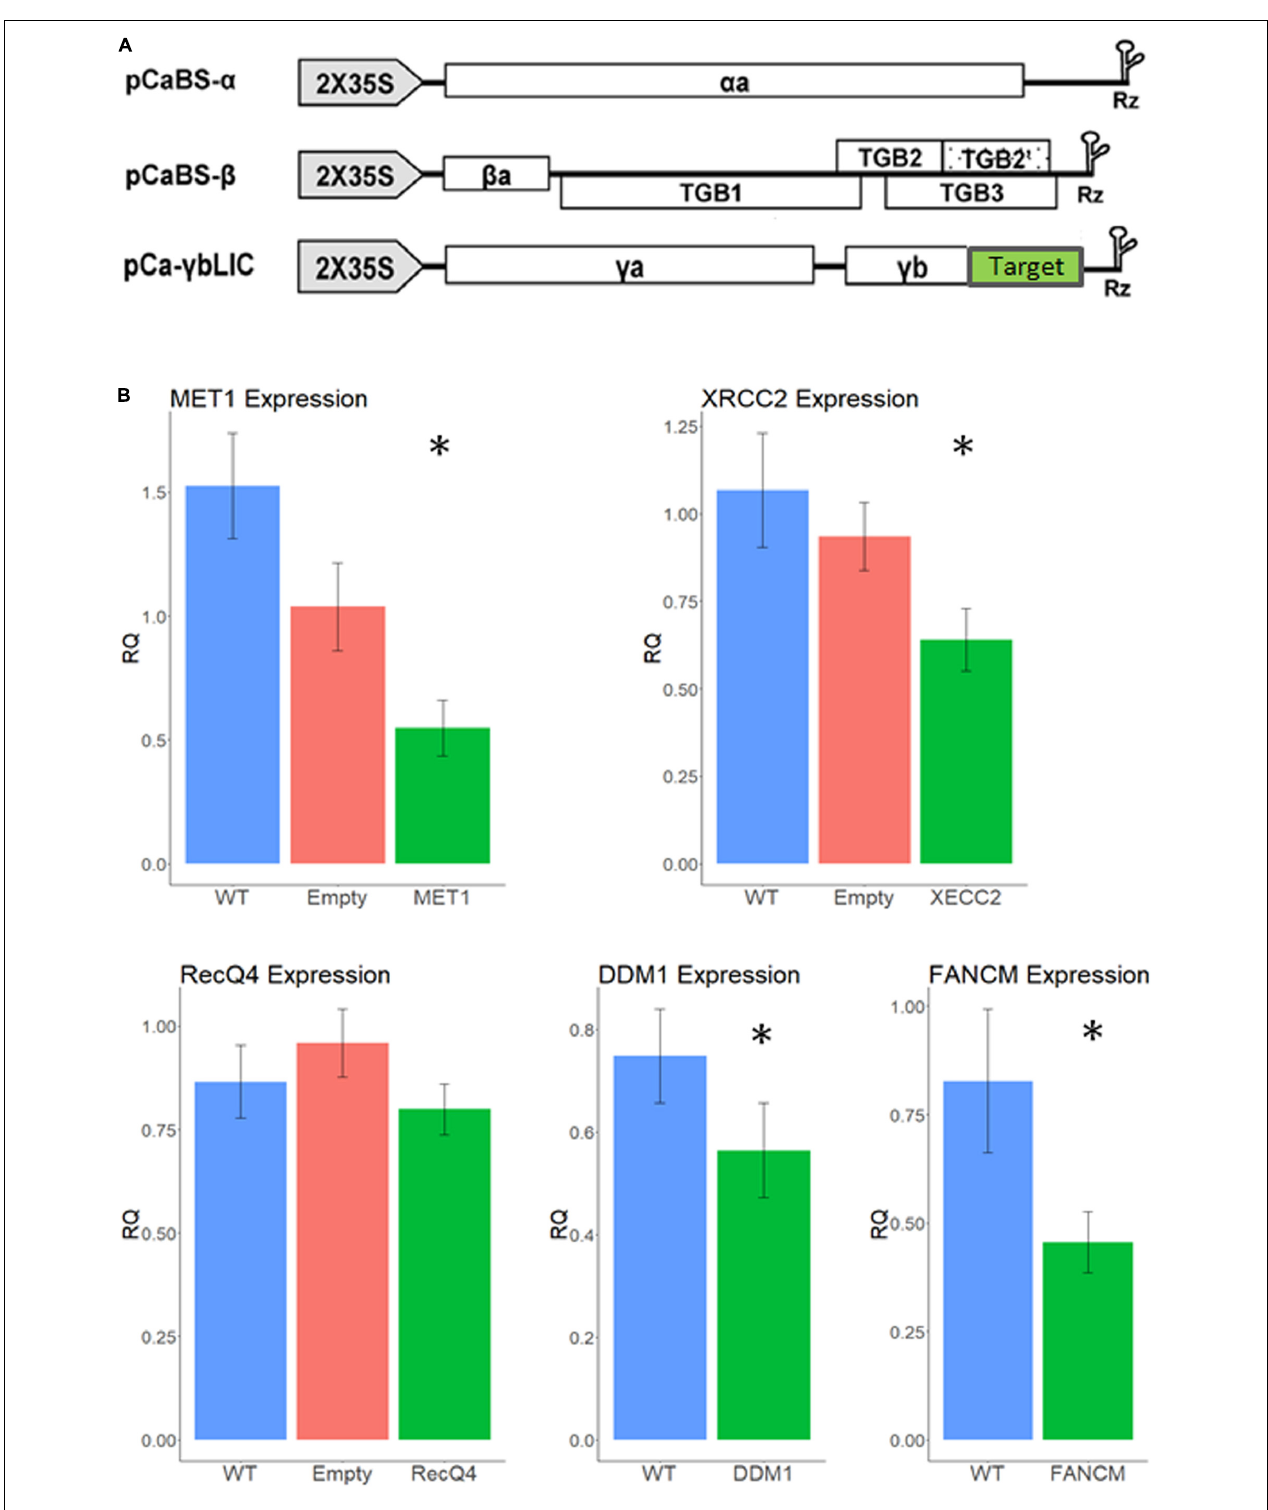
FIGURE 2 | Relative expression levels of recombination suppressor genes after infection with different VIGS treatments. (A) VIGS constructs. Each of the three BSMV sub-genomes was cloned into the pCass4-Rz binary vector under the 35S promoter. Target (green box) correspond to the gene of interest sequence (Adapted from Yuan et al., 2011). Vectors were introduced into N. benthamiana leaves for viral propagation and extracts from these leaves were used for wheat infection. (B) Silencing effect by VIGS treatments. Normalized relative expression is shown on the Y axis for each gene studied; WT, un-infected plants. Empty – infection with empty virus. Asterisk designate significant difference from WT ( p < 0.05, N = 15). Error bars represent